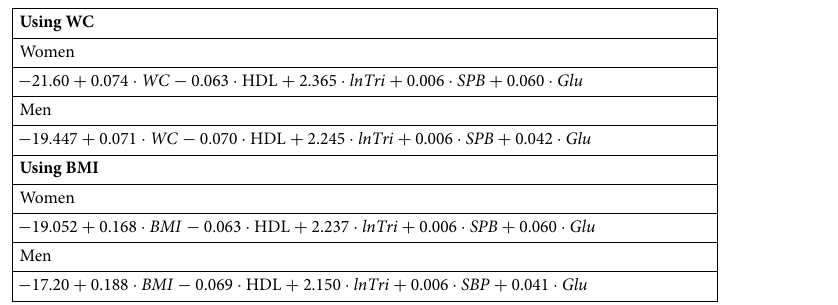
Table 4. MetSx by sex for Mexican adults.